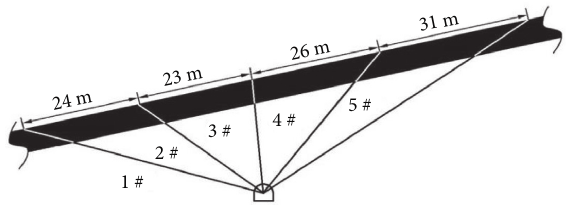
Figure 4: Borehole design